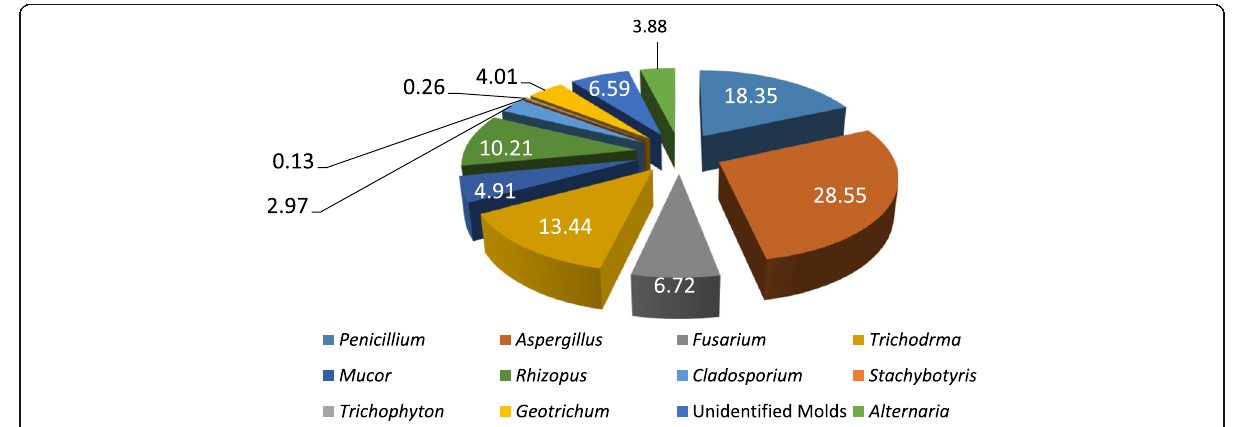
Fig. 1 Percentage distribution of fungal genera that were isolated from pharmaceutical waste sites ’